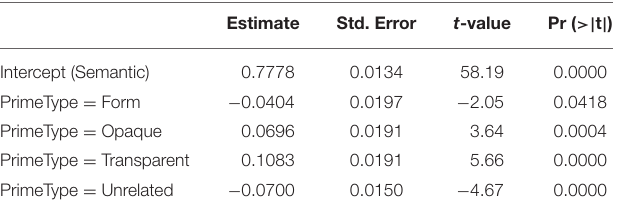
TABLE 4 | Effect of PrimeType in a linear model predicting cosine similarity, using treatment coding with the semantic condition as reference level.